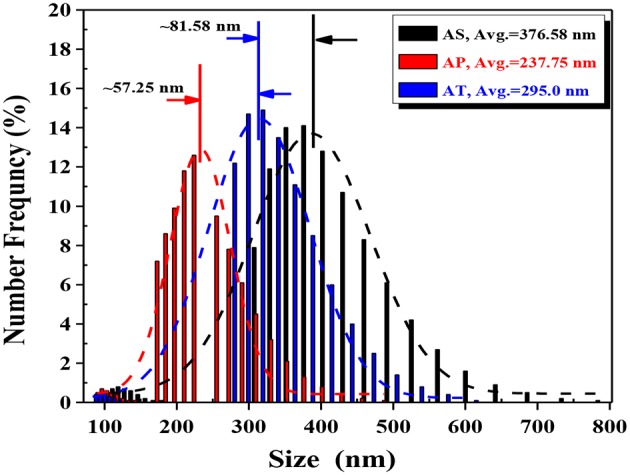
Particle size distribution histograms of dynamic light scattering (DLS) for the TiO2-based particles prepared. Average particle size is calculated from the Gaussian fittings of the histograms: Ag2O-TiO2 nanosphere (AS), Ag2O-TiO2 nanoplate (AP), and Ag2O-TiO2 nanotube (AT).